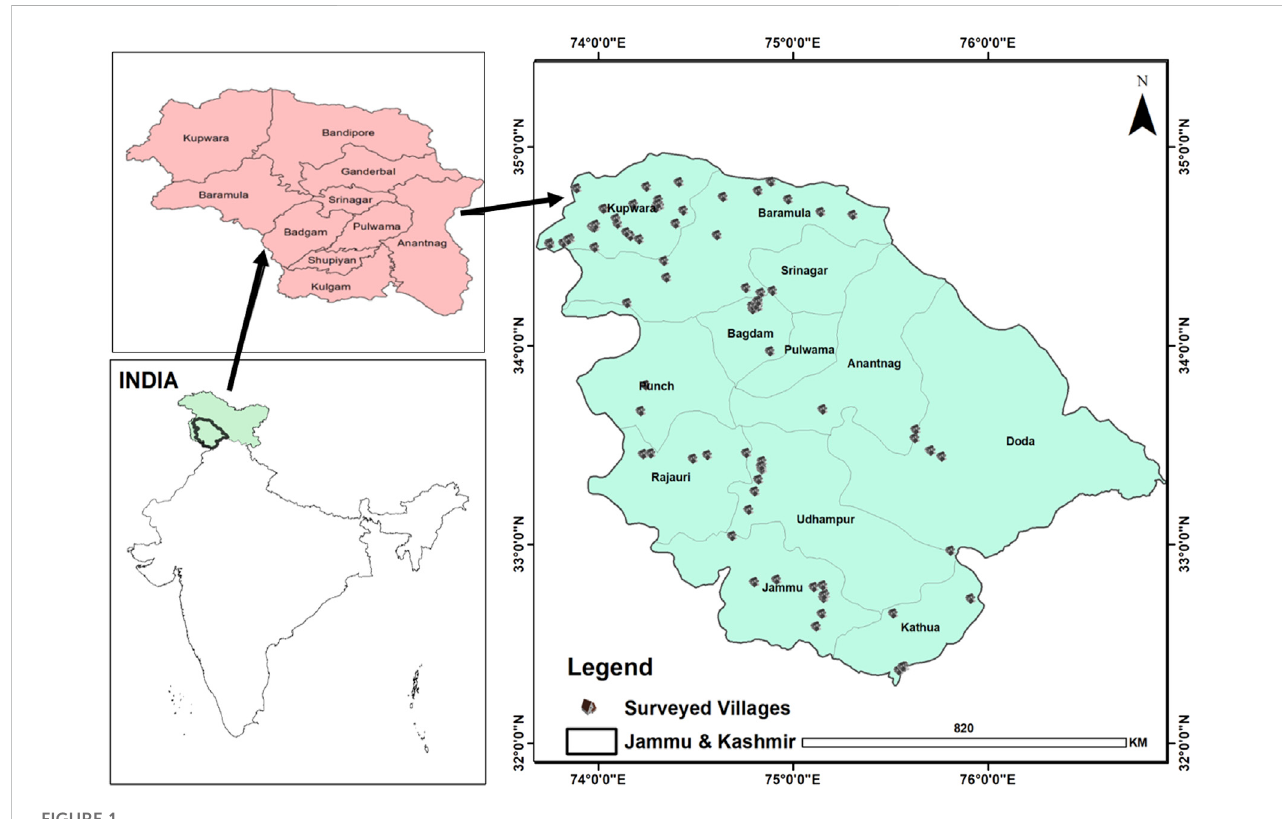
FIGURE 1 Map of Jammu and Kashmir, India; points show survey